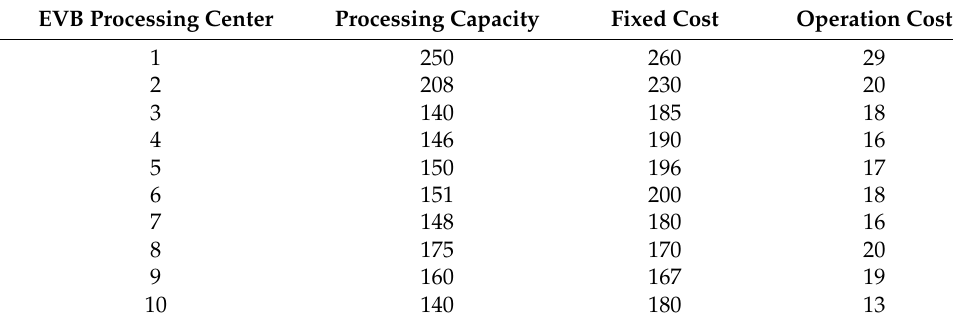
Table 2. Relevant parameters of EVB processing center.